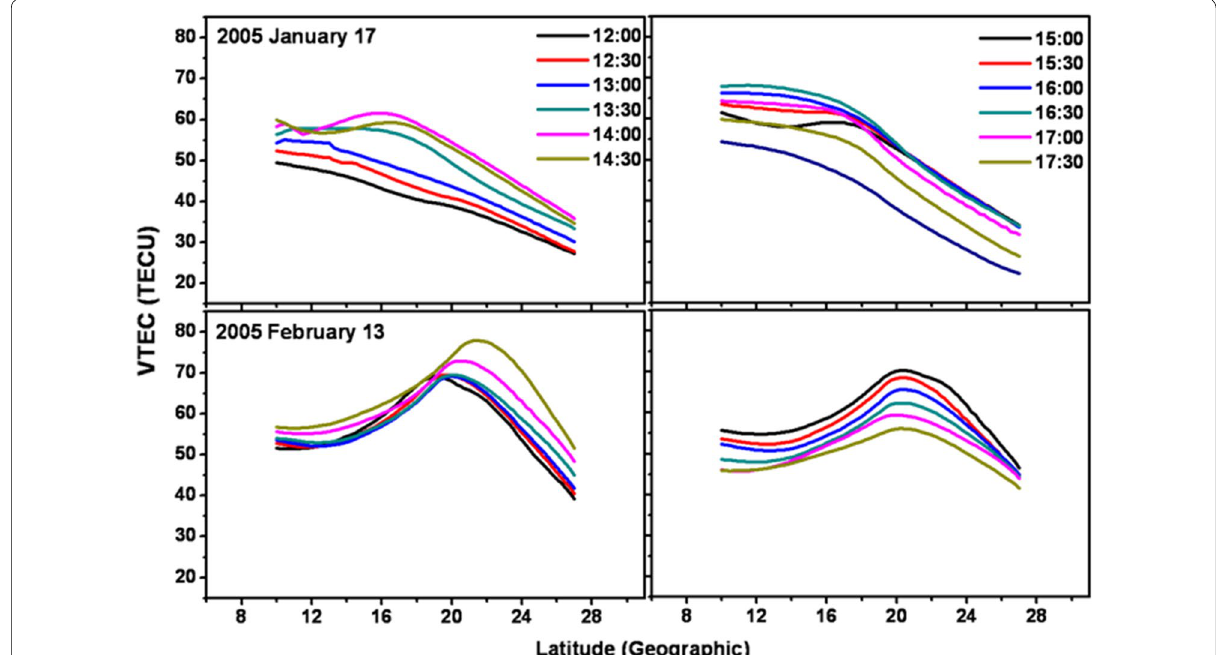
Fig. 3 Latitudinal variation of VTEC during the period 12:00–17:30 IST on January 17, 2005 (top panels) in comparison with the same for control day. The peak flare time is 15:20 IST